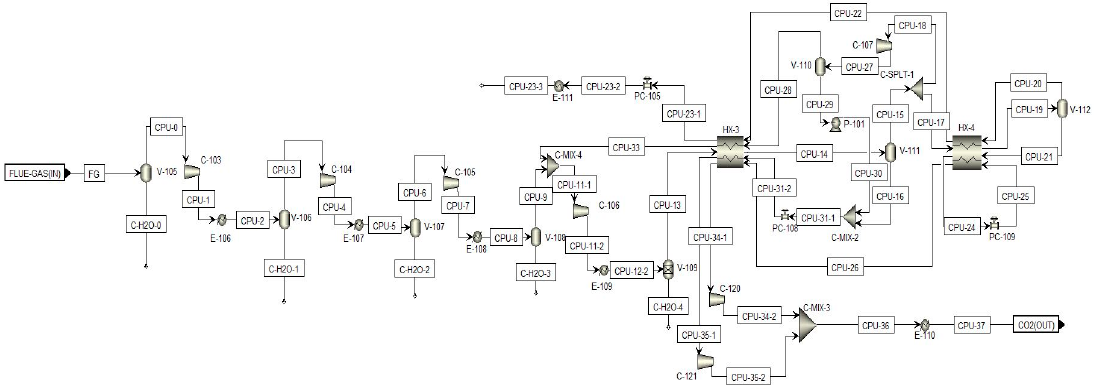
Figure 3. Aspen Plus CO 2 CPU flowsheet.